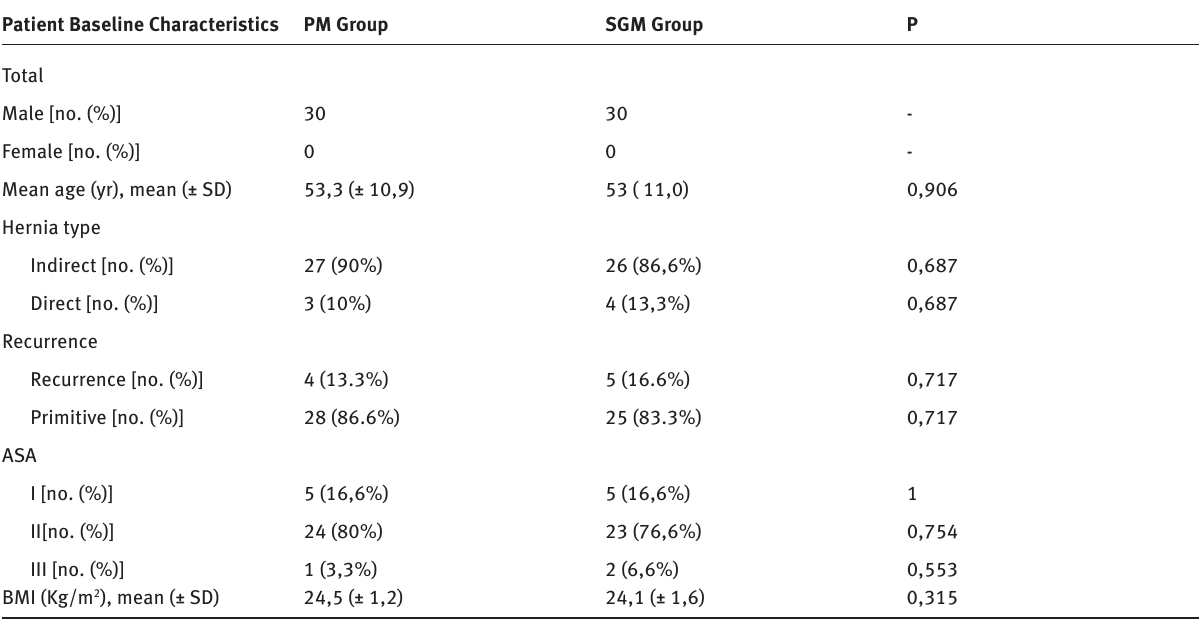
Table 1: Patient Baseline Characteristics